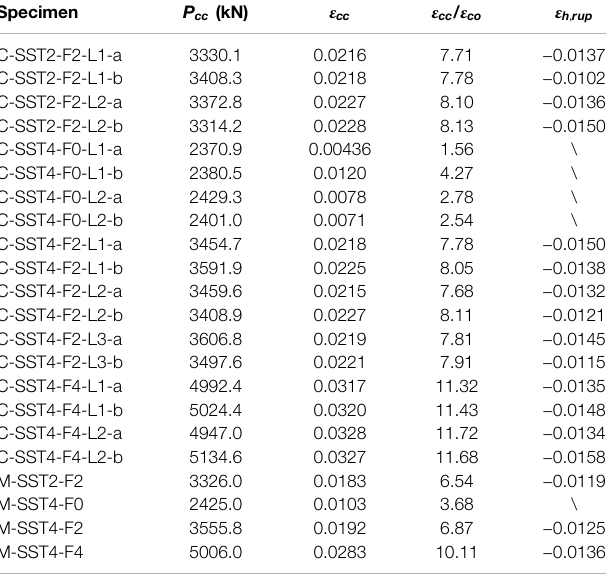
TABLE 4 | Summary of key test results.